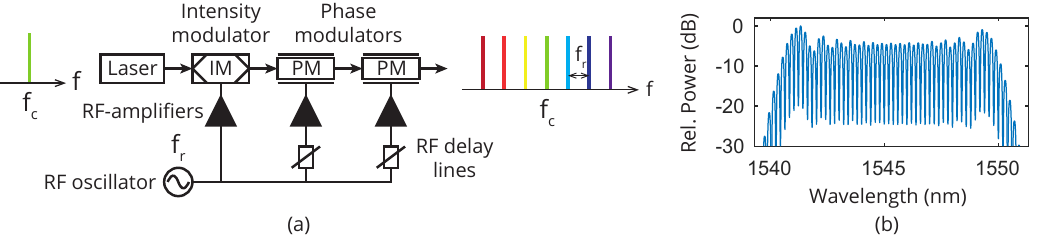
Figure 2. ( a ) A common setup of an electro-optic (EO) comb. A radio-frequency (RF) oscillator with frequency f r is used to phase- and intensity-modulate a continuous-wave laser, which creates an optical frequency comb with central frequency f c and frequency spacing f r . The RF delay lines are adjusted so that the intensity modulator carves out the part of the light where the phase modulation is mostly linear, which enables a relatively flat comb. Several phase modulators can be used to increase the modulation depth without increasing the RF input power to the modulators, which increases the total number of comb lines. ( b ) Measured spectrum of an